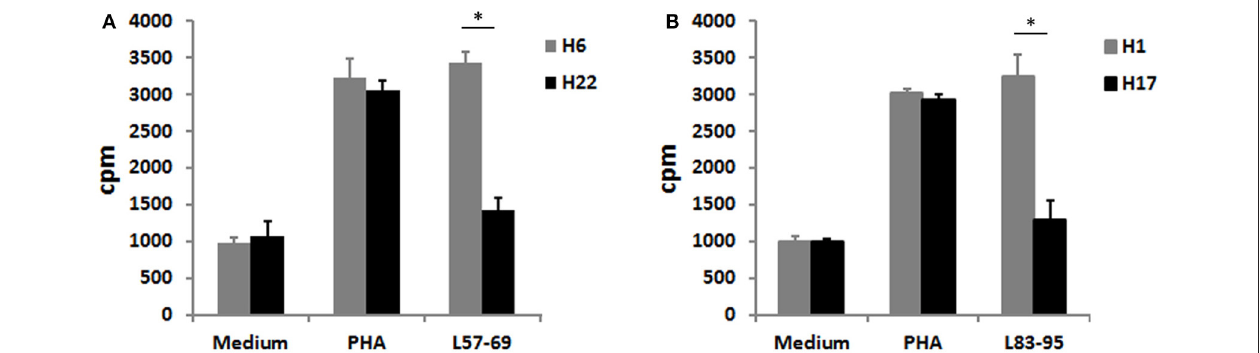
FIGURE 7 | (A) CD4 + T cells isolated from H. pylori -infected subject H6 and H22 were tested in proliferative responses to peptide L 57 – 69 (20 µ g/ml), phytohemagglutinin (PHA, 5 µ g/ml), and control medium. (B) CD4 + T cells isolated from H. pylori -infected subject H1 and H17 were tested in proliferative responses to peptide L 83 – 95 (20 µ g/ml), rLpp20 (5 µ g/ml), and control medium. CD4 + T cells treated with PBS were served as negative controls. CD4 + T cells treated with PHA were served as positive controls. All data were reported as means ± SD of three experiments. * p < 0.05 vs. control.